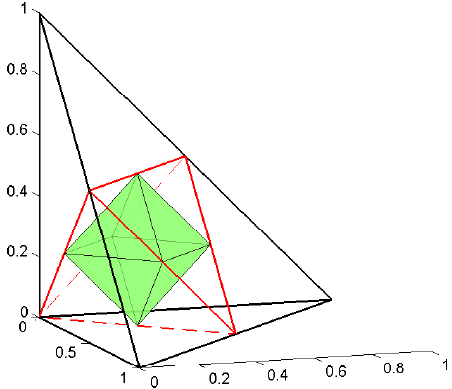
Figure 6. The four cells of type T of the subdivision of a cell of type M .